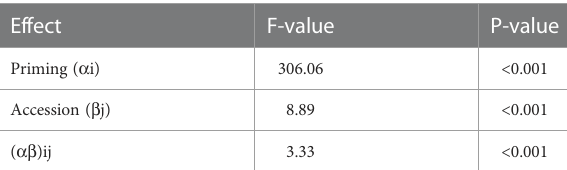
TABLE 2 Analysis of variances (ANOVA) of relative infection with P. hordei for the 198 accessions.